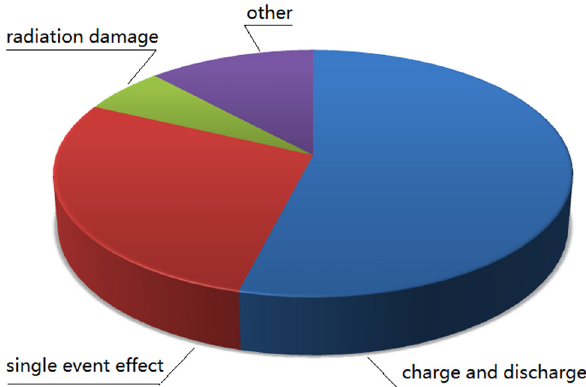
Figure 1: Satellite fault classi fi cation.